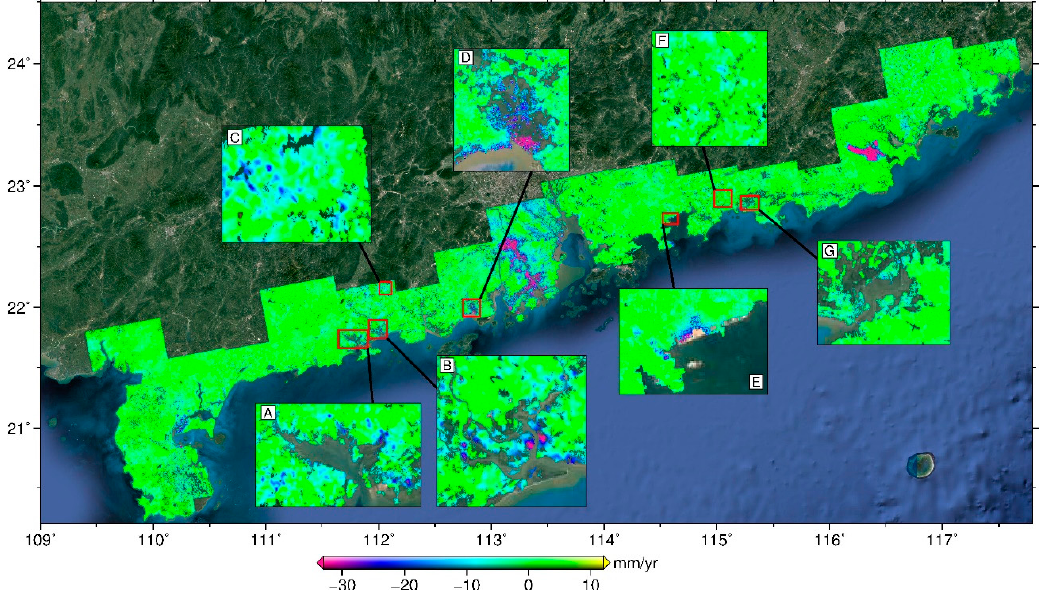
Figure 6. Average surface deformation map along the coastline of Guangdong. Yellow and purple shading represent surface motion toward and away from the satellite, respectively. Seven insets with obvious deformation rates are selected: ( A ) Hailing Bay, ( B ) the estuary of the Moyang River, ( C , F ) forest areas in tracks 463 and 457, respectively, ( D ) the estuary of Guanghai Bay, ( E ) the petrochemical area of Daya Bay, and ( G ) the estuary of the Haungjiang River.